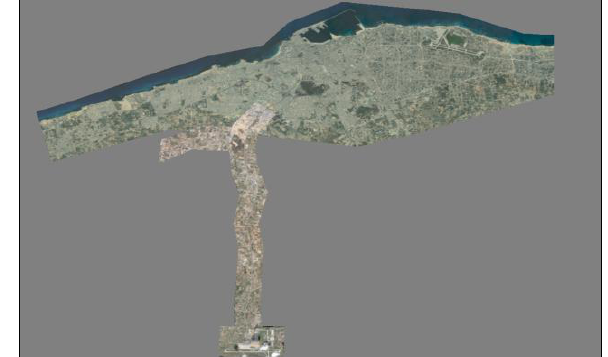
Figure 4. Satellite mosaics of